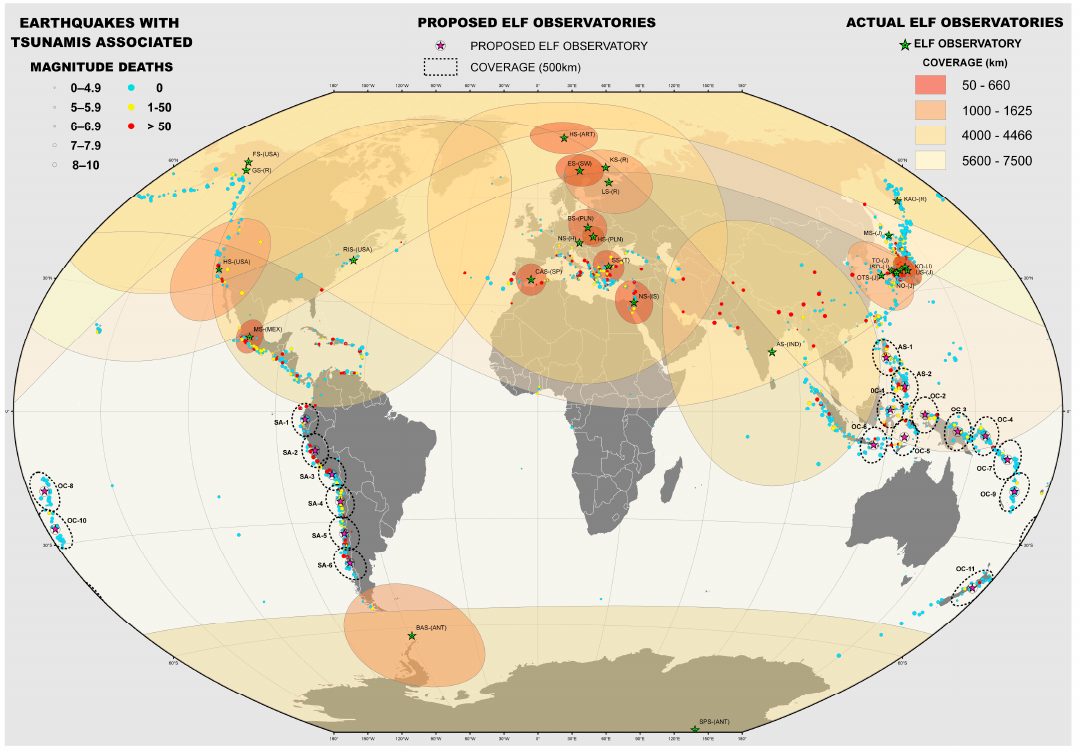
Figure 7. Tsunami risk alerts worldwide through proposed ELF observatories with a 500 km of radio. Table 3. Proposed ELF Observatories (500 km).